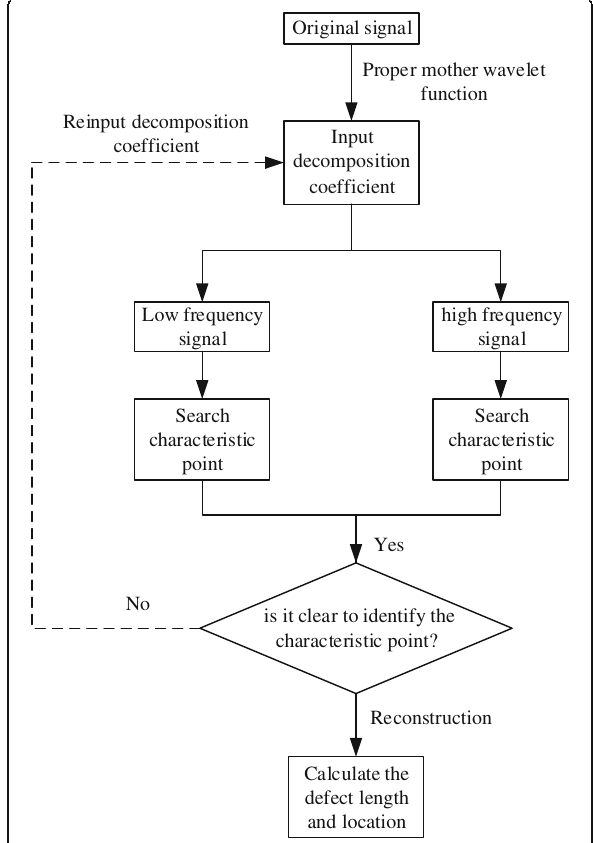
Fig. 2 The distinguishing flowchart for the defect length and position of hollow grouted rock